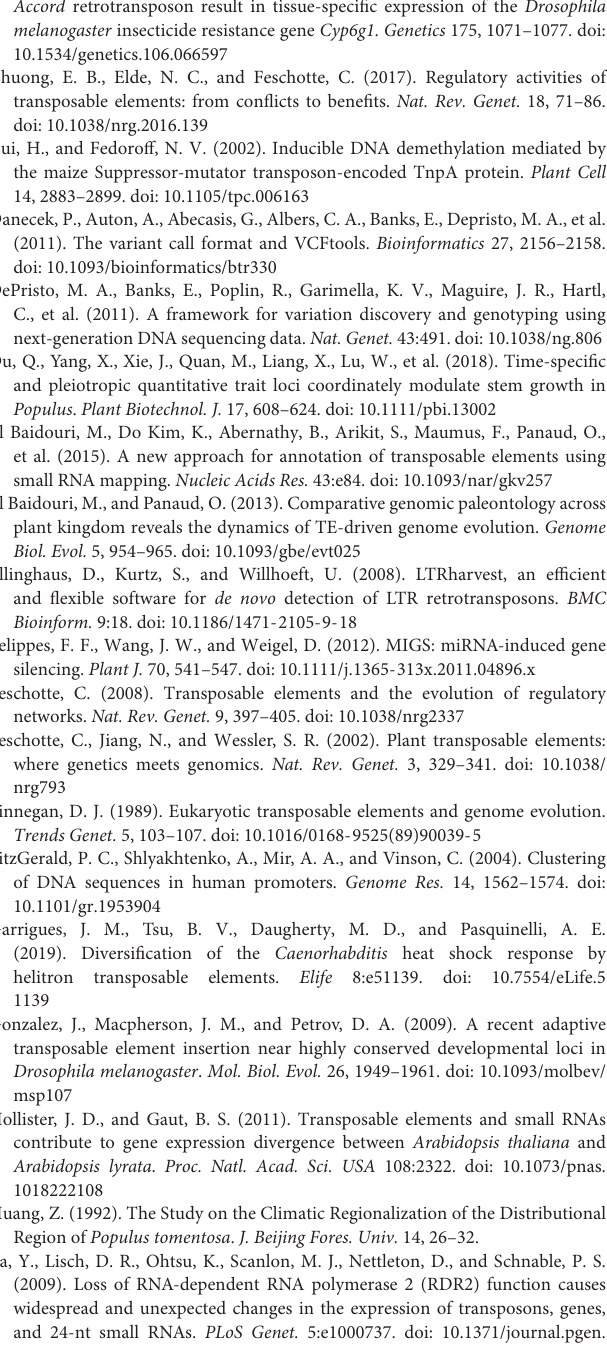
Supplementary Figure 7 | Diversity in P. tomentosa population. Supplementary Figure 8 | Adaptive selection signals within polymorphic TE insertions among the three P. tomentosa natural climatic regions. Supplementary Figure 9 | A adaptive TE within selection regions among the three P. tomentosa natural climatic regions. Supplementary Method 1 | Supplementary methods for this